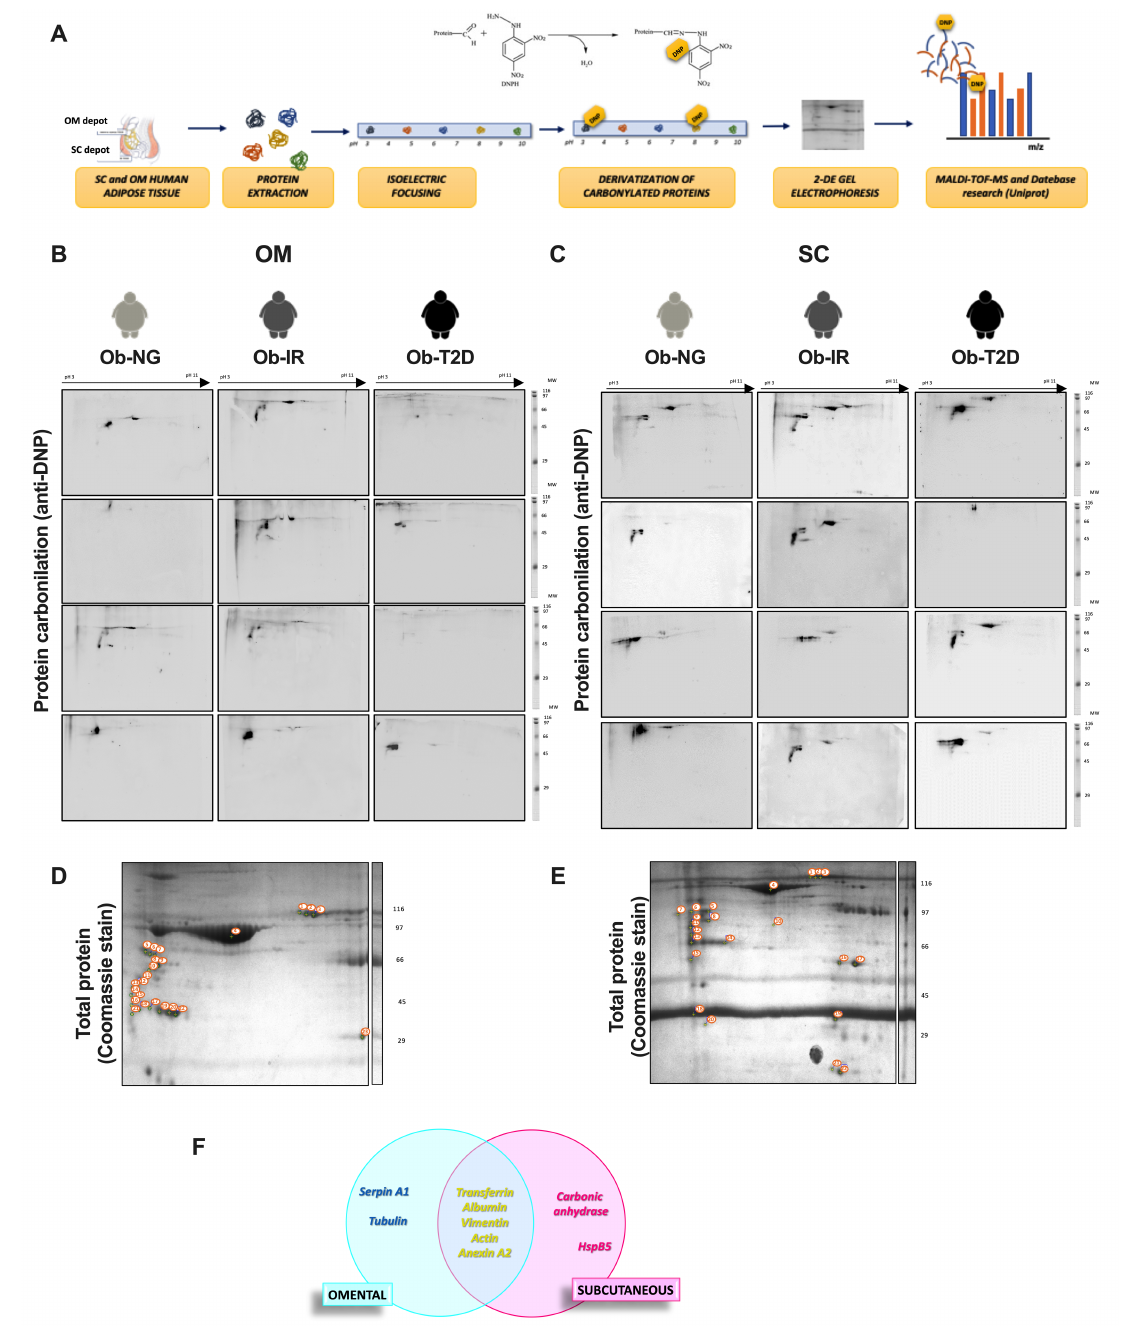
Figure 2. Analysis of the human adipose tissue carbonylome. ( A ) General workflow for the carbony- lome analysis in omental (OM) and subcutaneous (SC) human adipose tissue from obese normo- glycemic (Ob-NG), insulin resistance (Ob-IR), or diabetic (Ob-T2D) subjects. ( B , C ) Two-dimension gel electrophoresis (2D-PAGE) of total carbonylated protein in human adipose tissue in OM ( B ) and SC ( C ) fat depot in obese subjects using anti-DNP antibody. ( D , E ) Representative image of total adipose tissue proteome of pooled whole adipose tissue from OM ( D ) and SC ( E ) depot using Coomassie staining. Proteins were separated on a 2-DE gel using 18 cm pH 3–11 NL strips in the first dimension and 10% SDS-PAGE gels in the second dimension. Molecular weight standards were loaded on the second dimension (right). Differentially expressed proteins between the two adipose tissue depots are indicated with arrows. The numbers corresponding to the spot numbers are listed in Table 2. ( F ) Venn diagram showing the number of common and specific carbonylated proteins in (OM) and (SC) human adipose